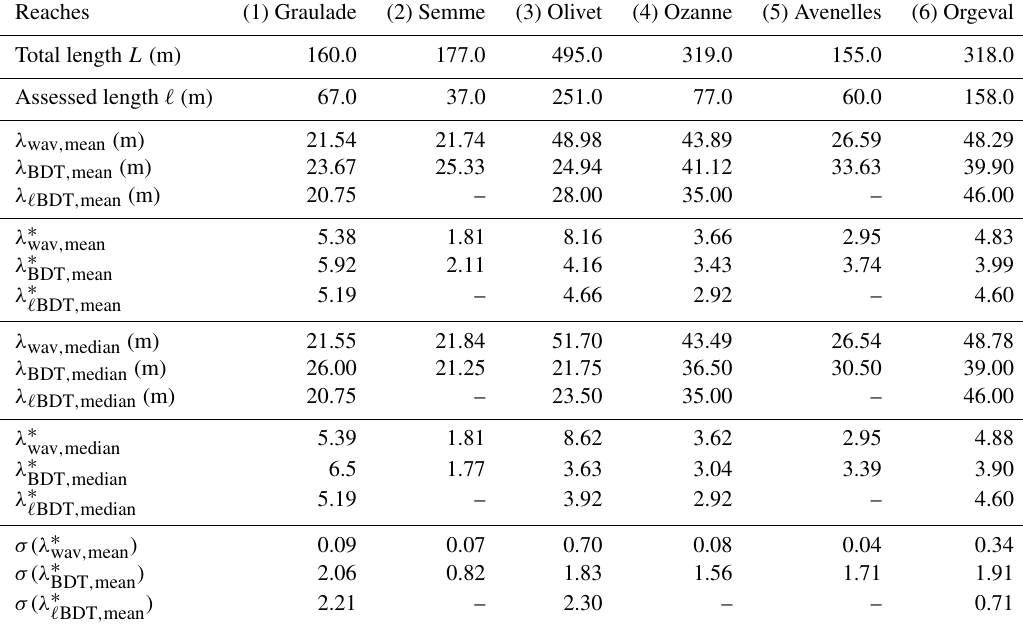
Table 5. Results of BDT and the multivariate wavelet methods for all reaches. λ meth , mean is the mean wavelength using one of the methods (for BDT, it used on the total length and the assessed one (cid:96) ). λ meth , median is the median, and λ ∗ λ ∗ is the median, and σ(λ meth , median ) is the standard deviation of the longitudinal spacing. (–) means that we find only one meth , median longitudinal spacing, which is the mean and the median, so there is no standard